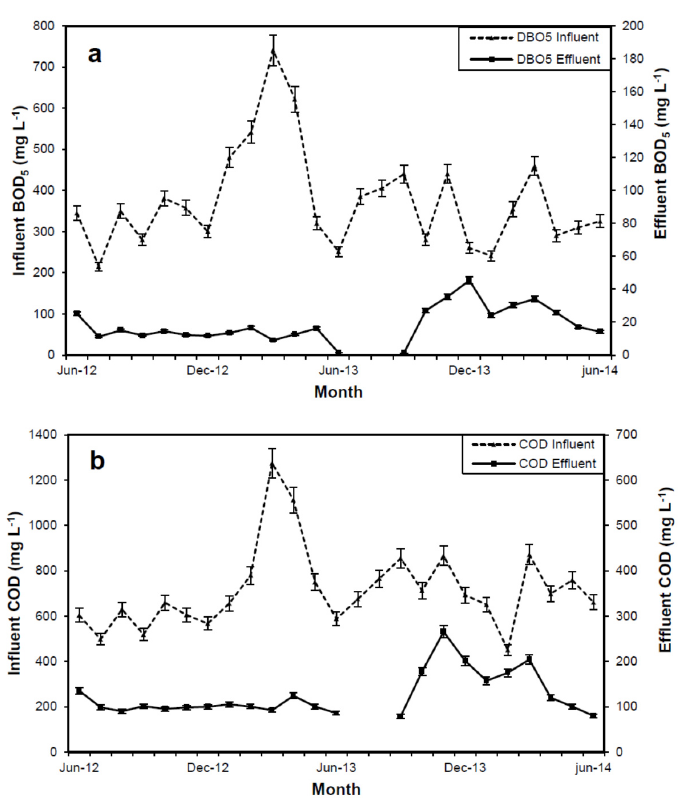
Figure 2. ( a ) Biochemical oxygen demand over five days (BOD 5 ) and ( b ) Chemical oxygen demand (COD) concentrations at the influent and the effluent of the studied horizontal subsurface flow constructed wetland.